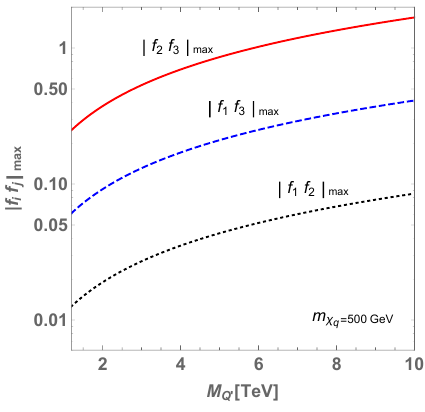
Figure 2 . The upper limits of | f i f j | as functions of M Q 0 where we fix m χ maximal values have relation of | f